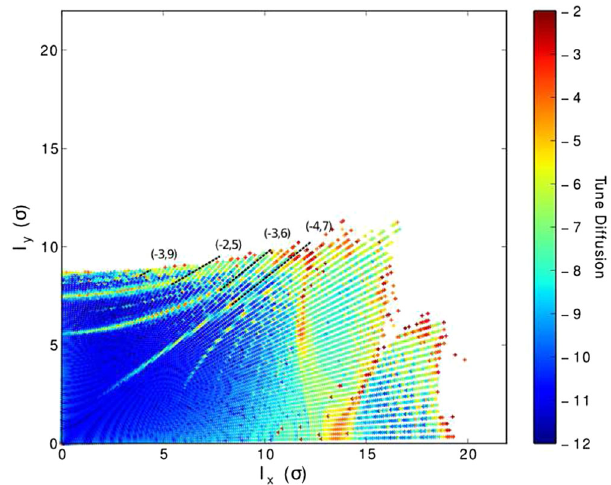
FIG. 19. Diffusion factor D over the initial amplitudes I ¼ 0 – 22 σ and 90 initial angles for the lattice L (cid:1) ¼ 10 m and β (cid:1) ¼ 10 cm.